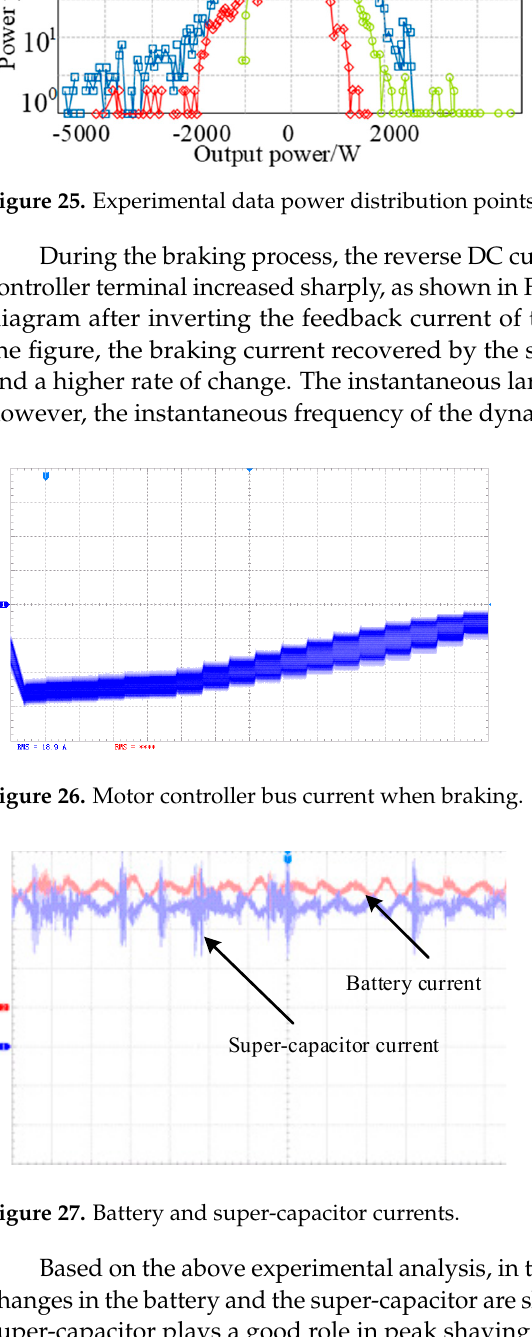
Figure 25. Experimental data power distribution points.